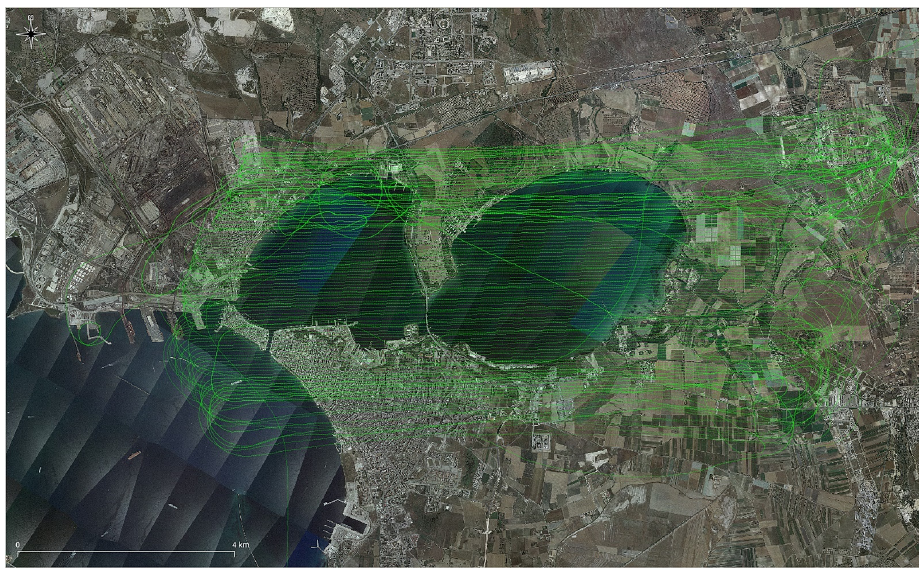
Figure 5. All flight paths from the logbook.